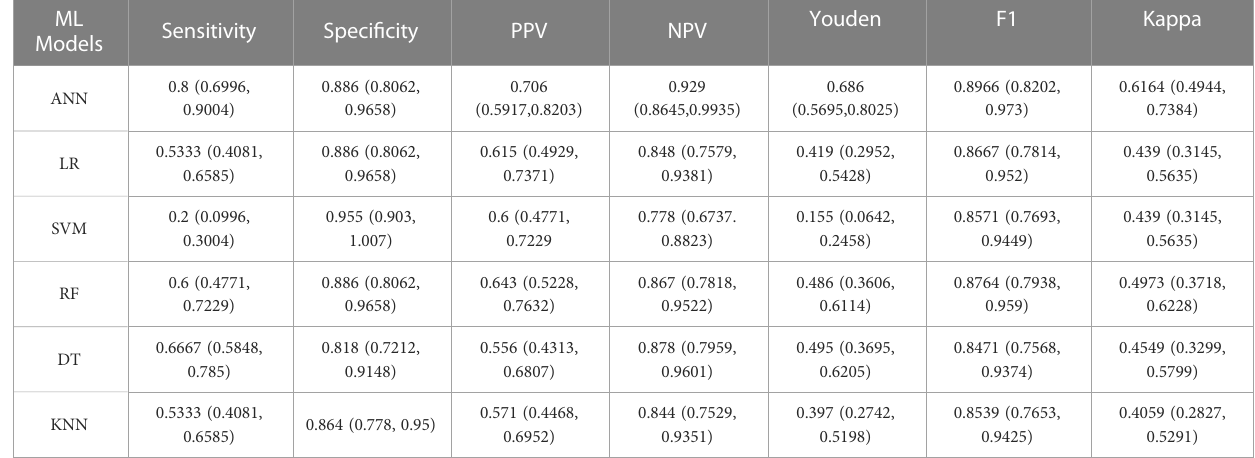
TABLE 2 Results for six machine learning models evaluated for the ef fi cacy of clinically signi fi cant prostate cancer test data. ML